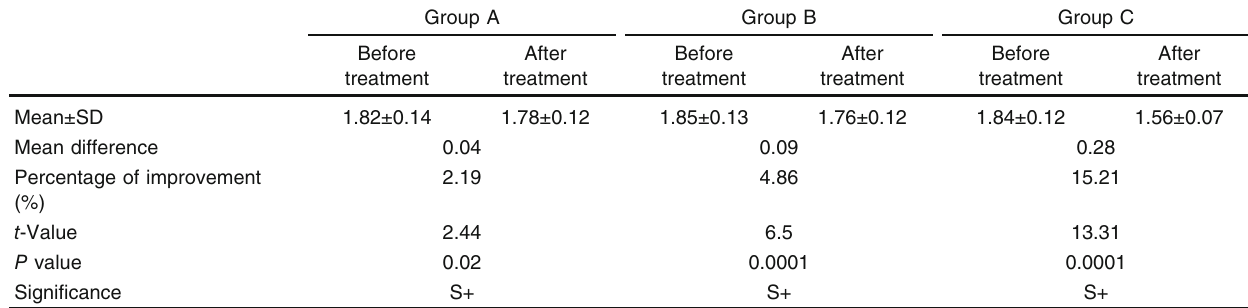
Table 3 Mean and±SD, t -value and P value of the pretreatment and post-treatment values of the forward head posture of groups A, B, and